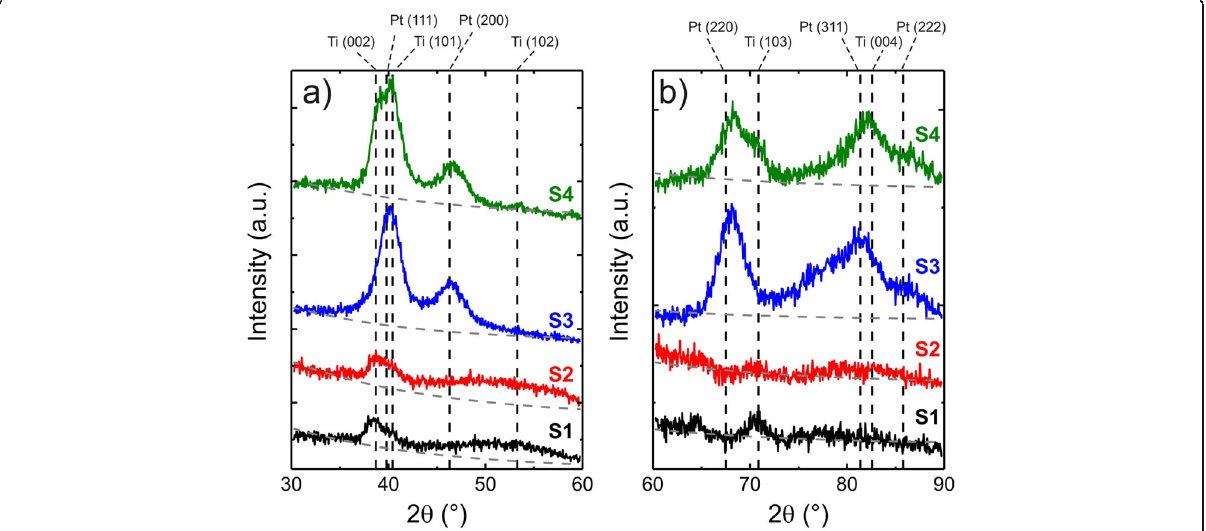
Fig. 3 GIXRD patterns from samples S1 – S4 of the a 30 to 60° diffraction angle range and ( b ) 60 to 90° range. The dashed gray lines represent exponential decay baselines that originate from diffuse X-ray scattering. The vertical dashed black lines correspond to the different diffraction planes of Ti and Pt, labeled at the top of a and